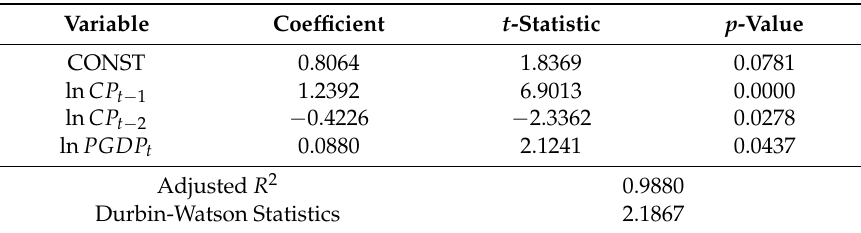
Table 4. Result of base linear dynamic